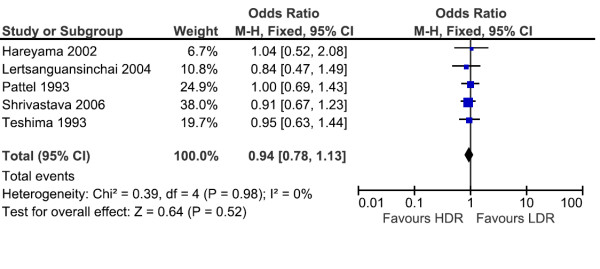
Overal mortality for all clinical stages in cervix cancer.